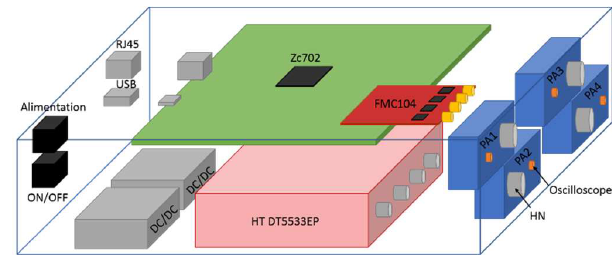
Figure 1: MONACO V2 3D synoptic [5] and 19” rack integration.